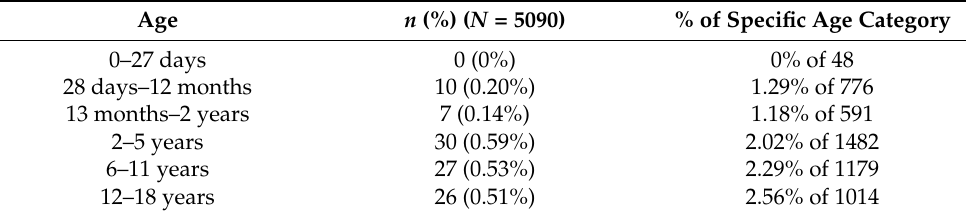
Table 7. Failed procedure in terms of age of the child.